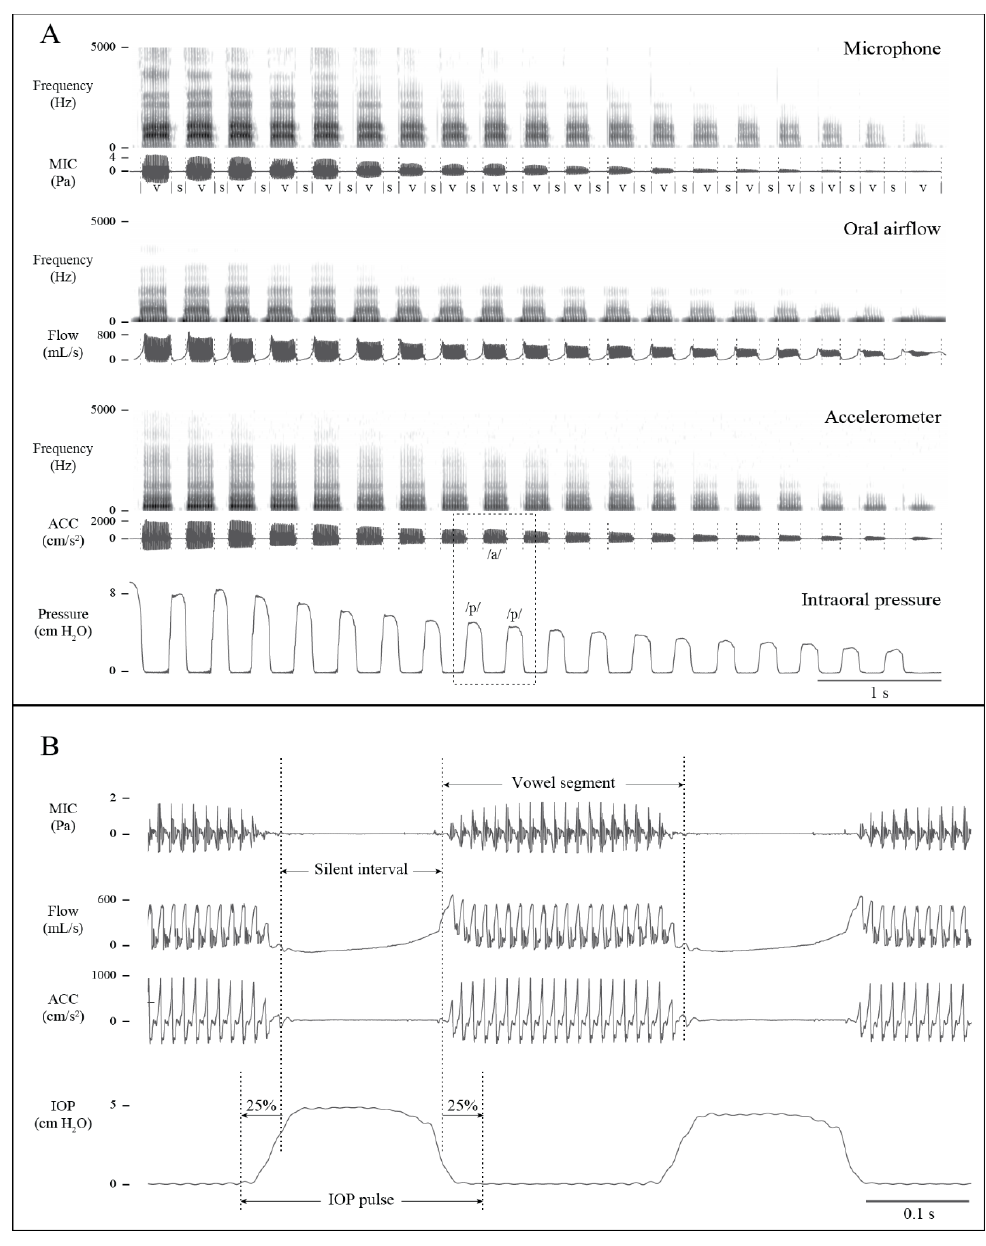
Figure 2. Illustration of how reference estimates of subglottal pressure were defined in a male study participant with a typical voice (M01) in modal phonation. ( A ) Time-aligned signals and associated spectrograms are plotted for the acoustic microphone (MIC), oral airflow, neck-surface accelerometer (ACC), and intraoral pressure (IOP) sensors (S = silence; V = vowel). A zoomed-in version of the boxed region is displayed in ( B ) to illustrate the definition of each vowel segment, silent interval, and IOP pulse. IOP